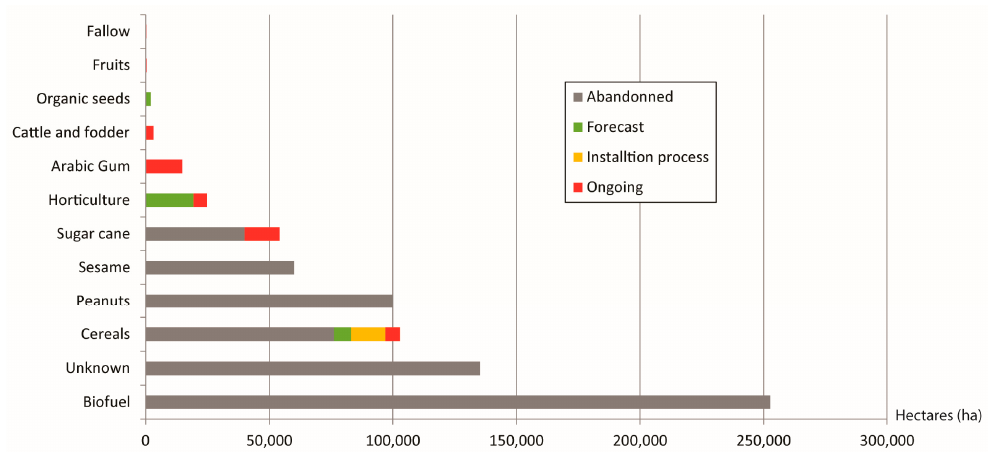
Figure 4. Status of the different crops cultivated or intended by agro-industrial